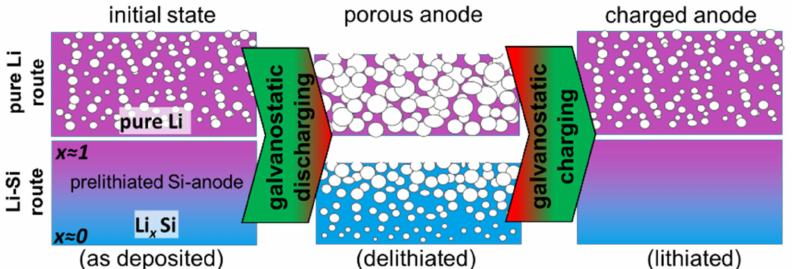
Figure 1. Concept for the synthesis of porous films by PVD of Li (purple) and Li-Si